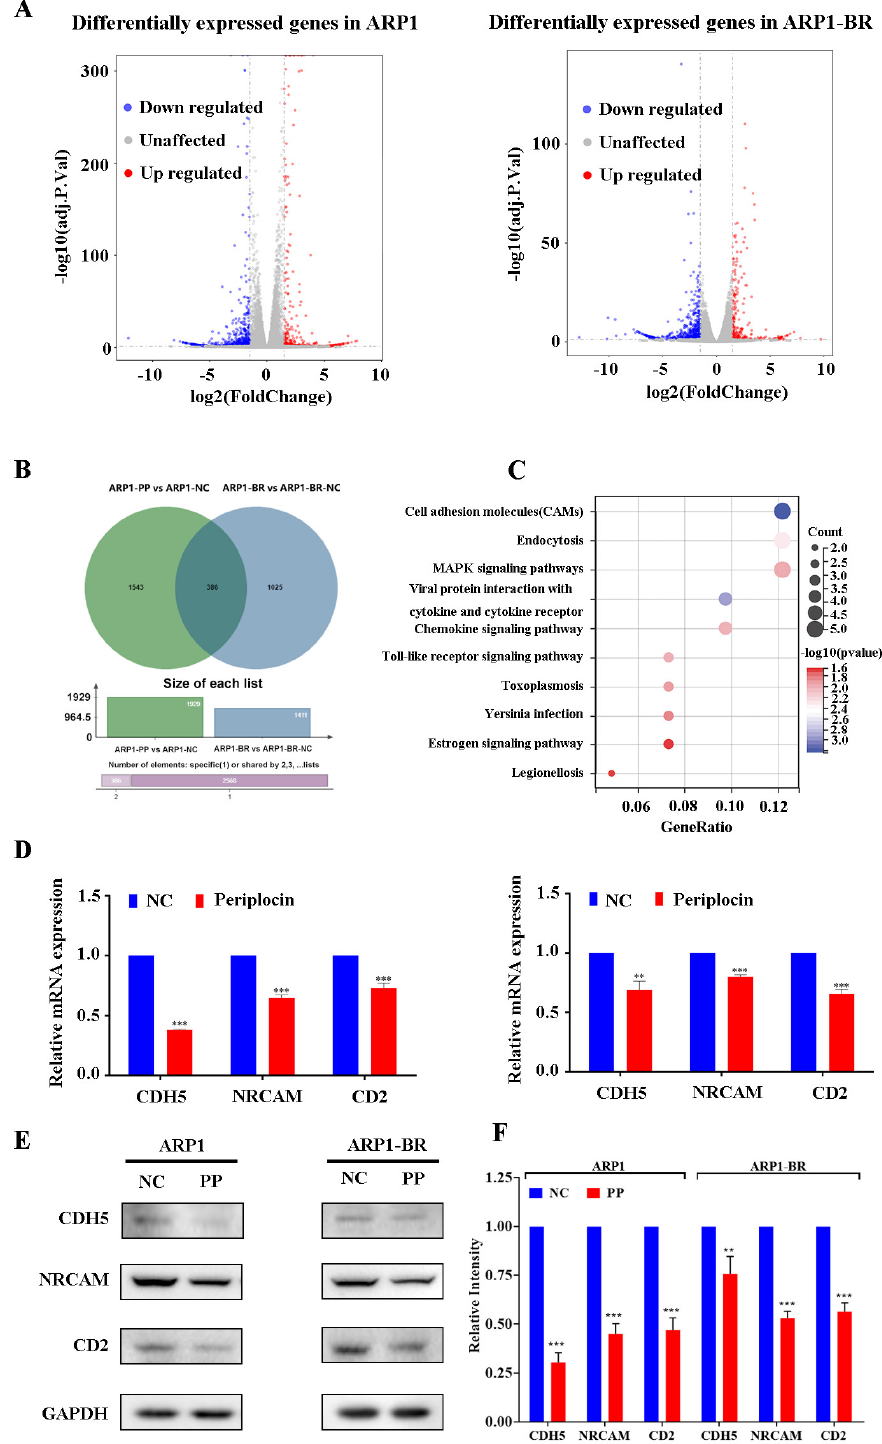
Figure 4. Periplocin downregulates cell adhesion molecules. ( A ) Transcriptome sequence analysis of differentially expressed genes by differential gene volcano map in RNA-sequencing of pretreated ARP1 and ARP1-BR cells with PP at concentrations of 0 µ M and 0.5 µ M for 24 h. ( B ) Differential gene Venn diagram of transcriptome sequenced of PP pretreated ARP1 and ARP1-BR cells. ( C ) Identi- fication of CAMs as the most significantly co-enriched genes through KEGG pathway analysis in RNA-sequencing of pretreated ARP1 and ARP1-BR cells with PP at a concentration of 0 µ M and 0.5 µ M for 24 h. ( D ) Identification of significantly reduced expression of CAMs genes CD2, CDH5, and NRCAM at mRNA levels through real-time qRT-PCR in ARP1 and ARP1-BR cell lines at 24 h of PP treatment at a concentration of 0 μM and 0.5 μM. ( E ) The significantly reduced expression of CAMs proteins of CD2, CDH5, and NRCAM genes at protein levels in ARP1 and